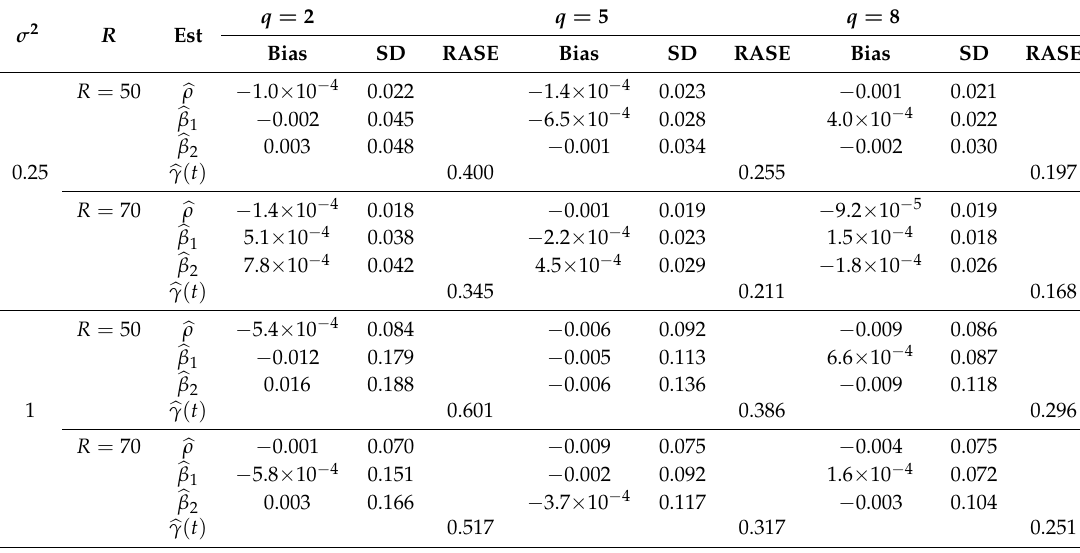
Table 1. Simulation results for ρ = 0.2.